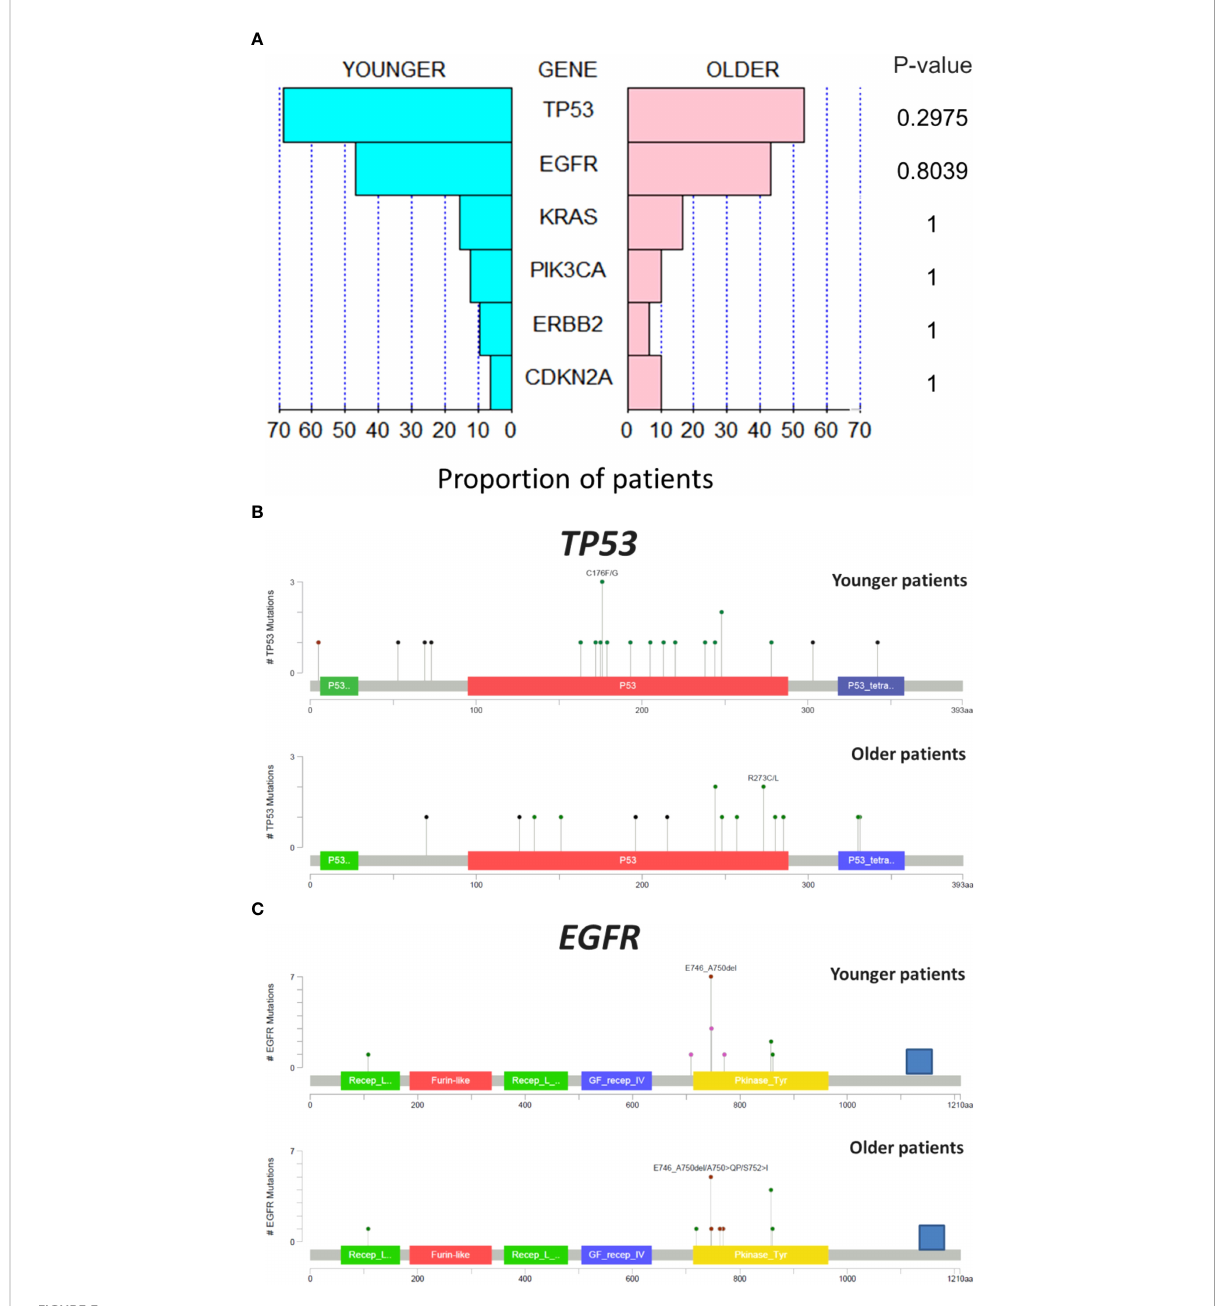
FIGURE 3 Comparative analysis of mutation between age groups in genes more frequently altered (A) . Comparison between age groups of the structural alteration in p53 (B) and in EGFR (C)